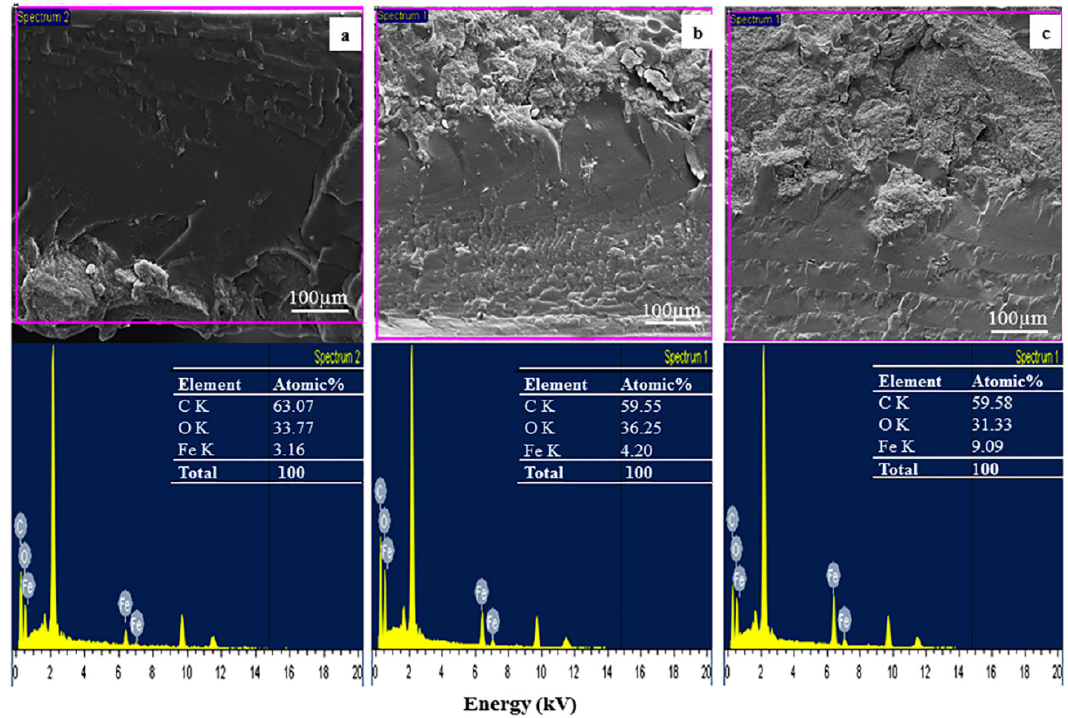
Figure 2. EDS analysis of ( a ) PVA/BM20, ( b ) PVA/BM40 and ( c ) PVA/BM60 composite films.